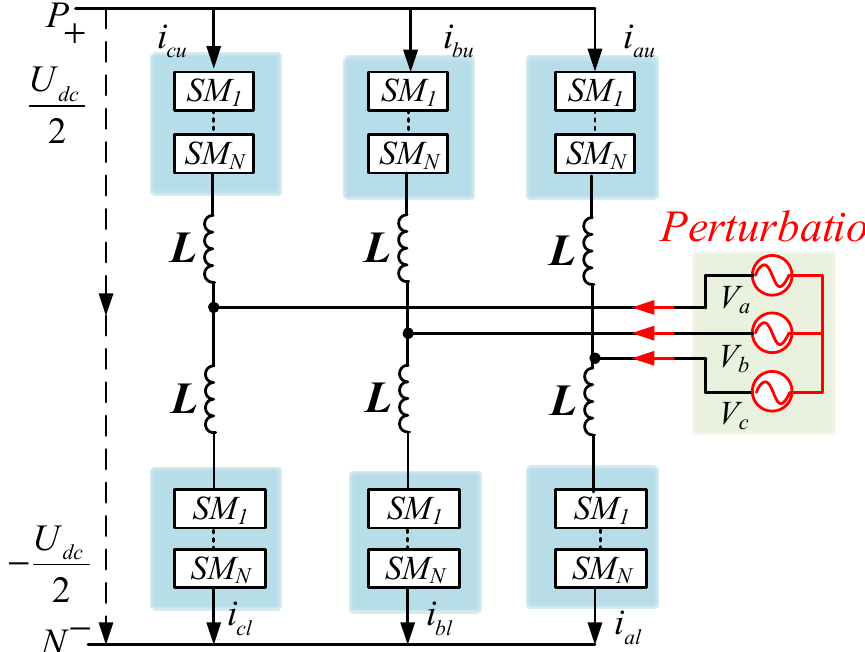
Figure 14. The configuration of MMC integrated with AC link voltage perturbation.